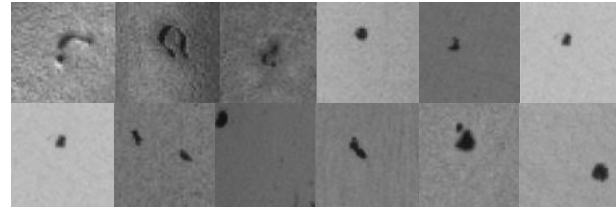
Figure 18. Examples of cropped flawed images.